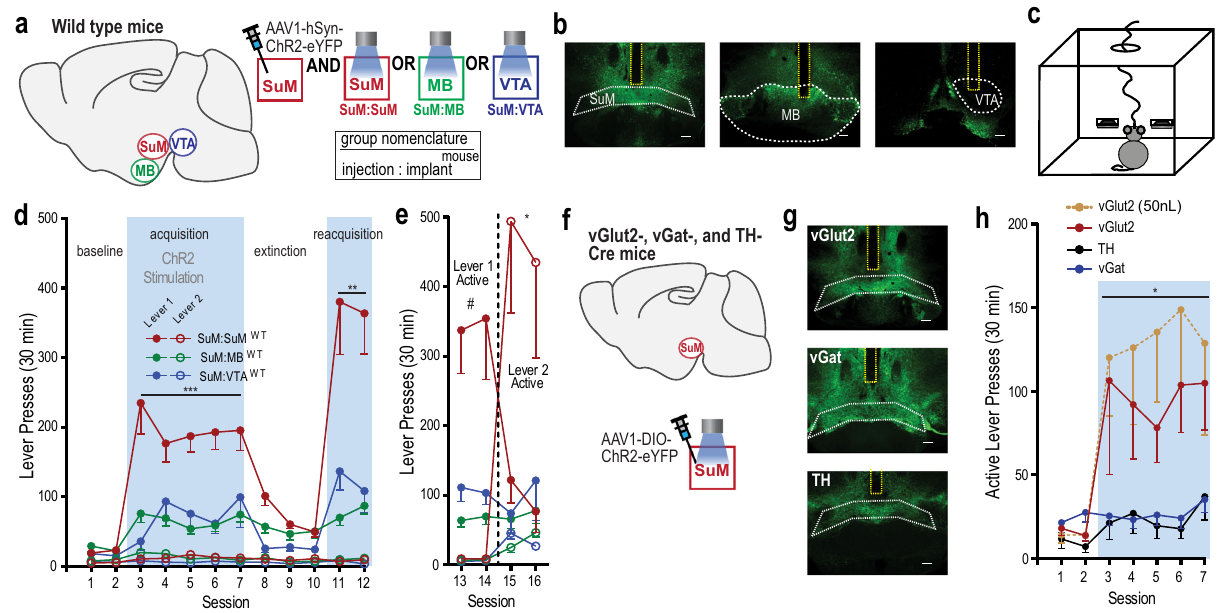
Fig. 1 Phasic excitation of SuM GLU neurons is reinforcing. a Schematic of hSyn-ChR2 viral injection targeting SuM neuron cell bodies and optic fi ber implantation targeting the SuM, MB, or VTA placements. The group nomenclature box describes how injection site and stimulation site are abbreviated (e.g., SuM:SuM). b Examples of histology showing ChR2-eYFP expression in SuM and surrounding tissues with optic fi ber placements (yellow dotted) in SuM (top), MB (middle), and VTA (bottom). Scale bar = 200 µ m. See Supplementary Fig. 1 for histological results of all mice ( n = 22). c Schematic of mouse operant-conditioning chamber equipped with two levers. d Active (closed circles) and inactive (open circles) lever presses per session (mean − SEM). SuM-stimulation group has signi fi cantly higher ICSS rates than the other two groups during acquisition sessions 3 – 7 and reacquisition sessions 11 – 12. *** p < 0.001 and ** p < 0.01, with Tukey post hoc HSD test, SuM:SuM WT ( n = 10), SuM:MB WT ( n = 6), and SuM:VTA WT ( n = 6). All animals pressed very little on inactive lever, so their data are shown but not further analyzed. e Lever reversal experiment. The data are mean lever presses − SEMs. SuM- stimulation group responded on lever 1 signi fi cantly more than on lever 2 when lever 1 was active, # p < 0.012; and they reversed responding and responded on lever 2 signi fi cantly more than on lever 1 when lever 2 became active, * p < 0.001 (Tukey HSD post hoc test). See ( d ) for the n of each group. f Schematic showing Cre-speci fi c ChR2 viral injection targeting SuM neurons and optic fi ber implantation targeting SuM performed in vGlut2-Cre, TH-Cre, and vGat- Cre mice. g Examples of histology showing ChR2-eYFP expression in SuM in vGlut2-Cre (top), TH-Cre (middle), and vGat-Cre mice with optic fi ber tracts (yellow) in SuM. Scale bar = 200 µ m. See Supplementary Fig. 2 for histological results of all mice ( n = 46). h Active lever-presses per session (mean − SEM). vGlut2-Cre group ( n = 18) responded greater than TH- or vGat-Cre group ( n = 7 and 11, respectively), p vGlut2 vs TH = 0.037, p vGlut2 vs vGat = 0.016, p = 0.99 (Tukey HSD post hoc test). vGlut2-Cre groups consisted of the mice ( n = 6) that received a 50 nL volume of the AAV to minimize the vGat vs TH diffusion of the vector and the mice ( n = 12) that received 200 nL. Source data are provided as a Source Data fi